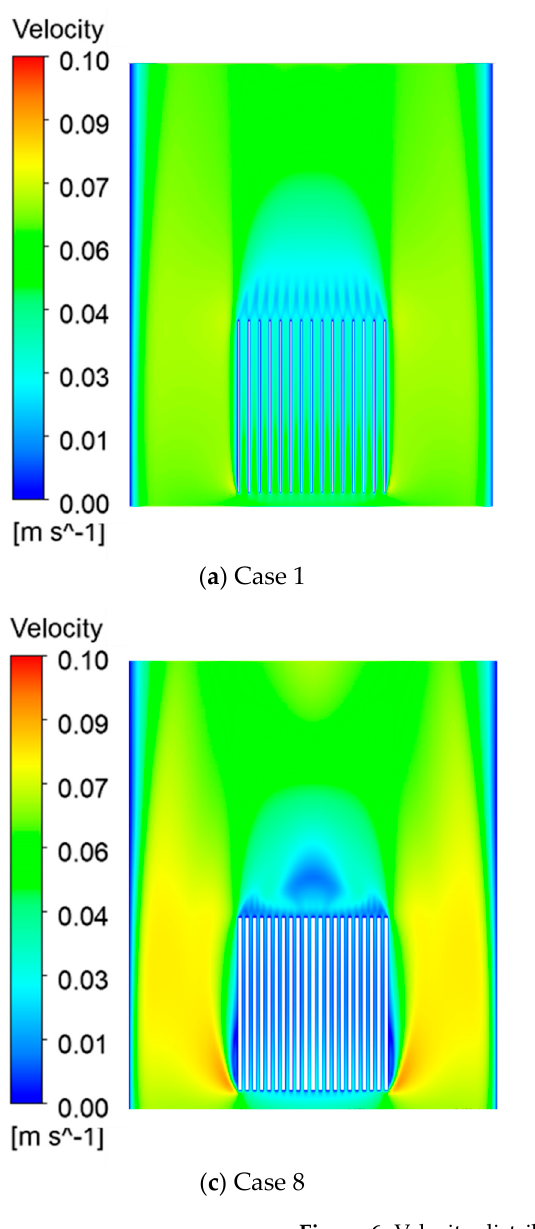
Figure 6. Velocity distribution of each case at x = 15 mm.